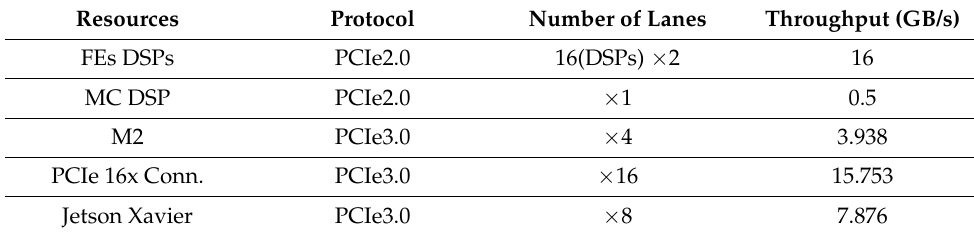
Table 2. Theoretical Resources